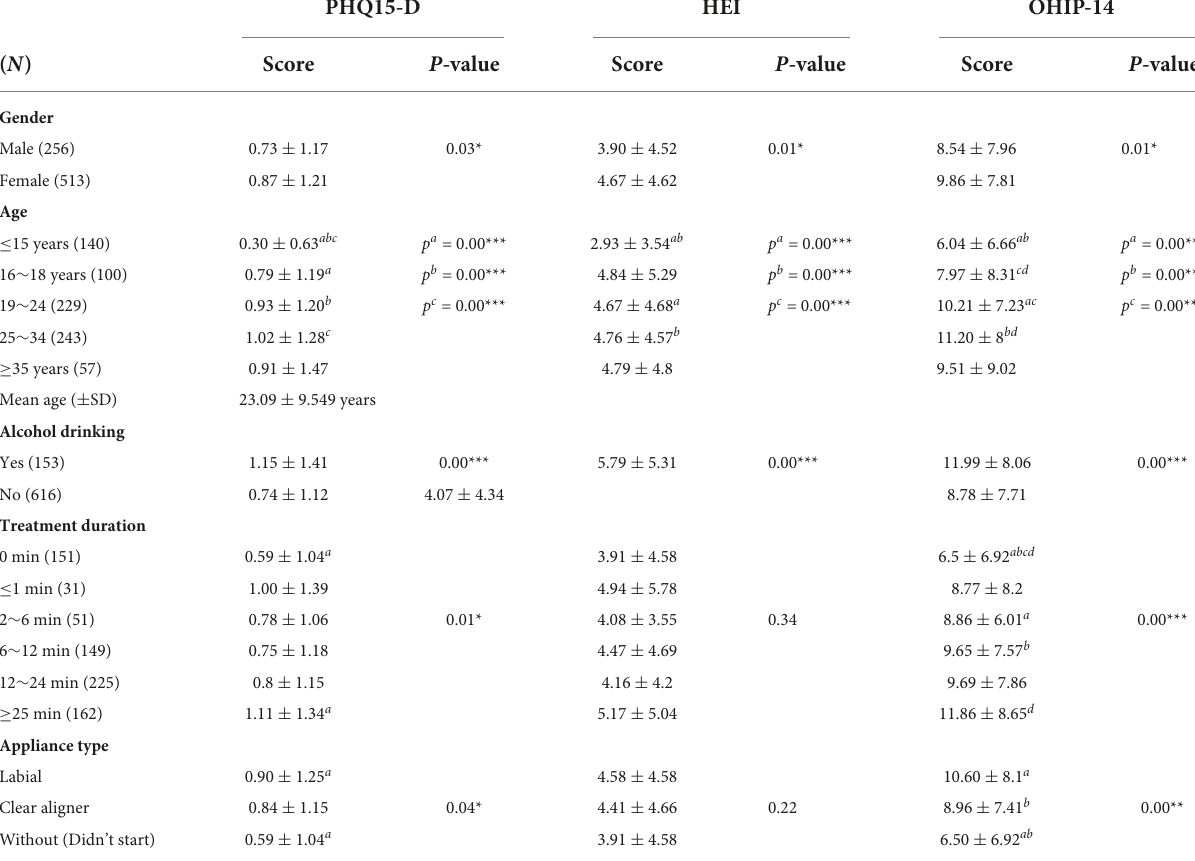
TABLE 1 Descriptive statistical